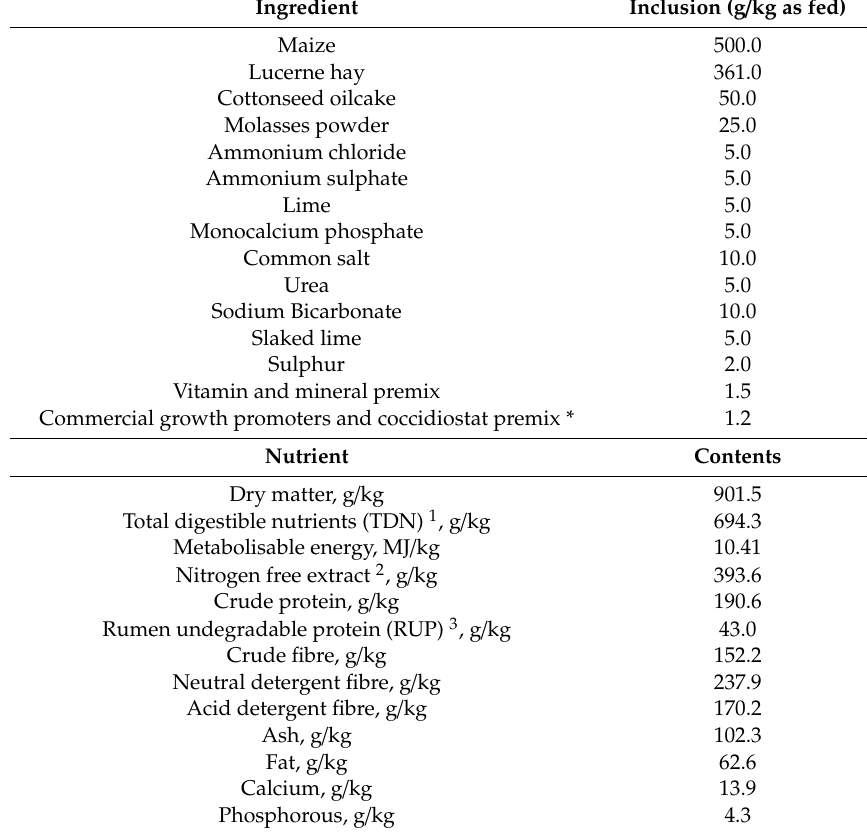
Table 2. Ingredient formulation and nutritional composition of feedlot diet fed to lambs during the study